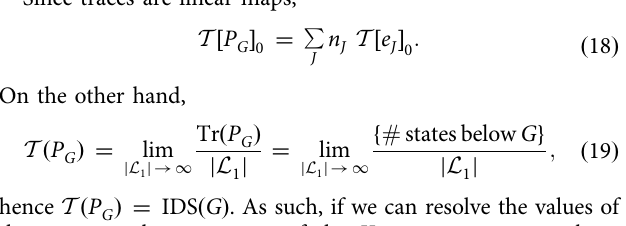
ffiffiffi p 7 . The fi ttings according to the theory are overlaid as dashed